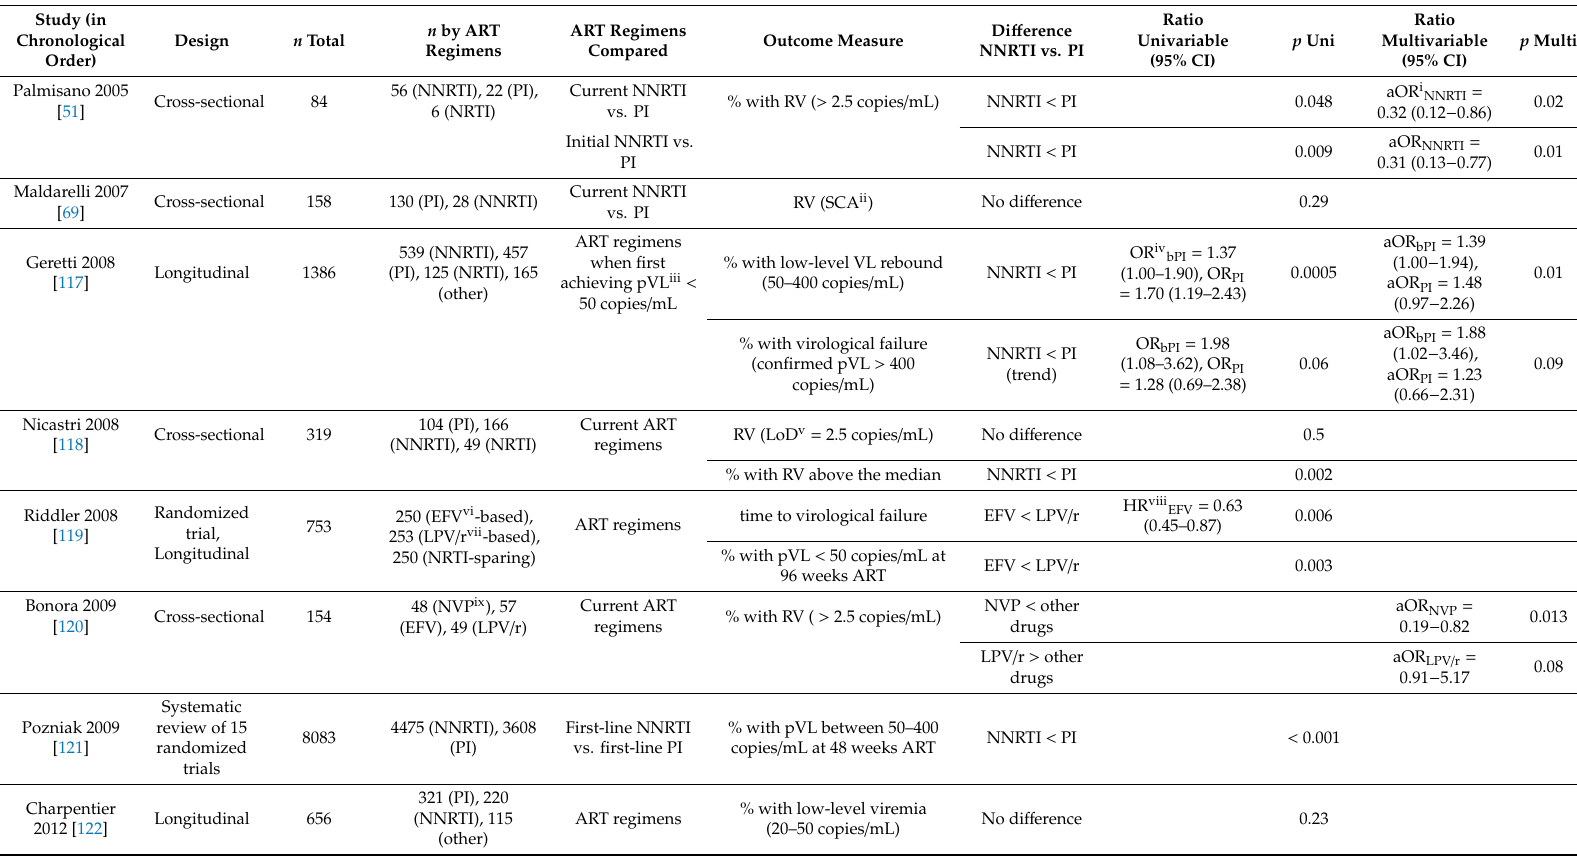
Table 1. Studies that compared low-level viremia and RV on ART between NNRTI- and PI-based triple